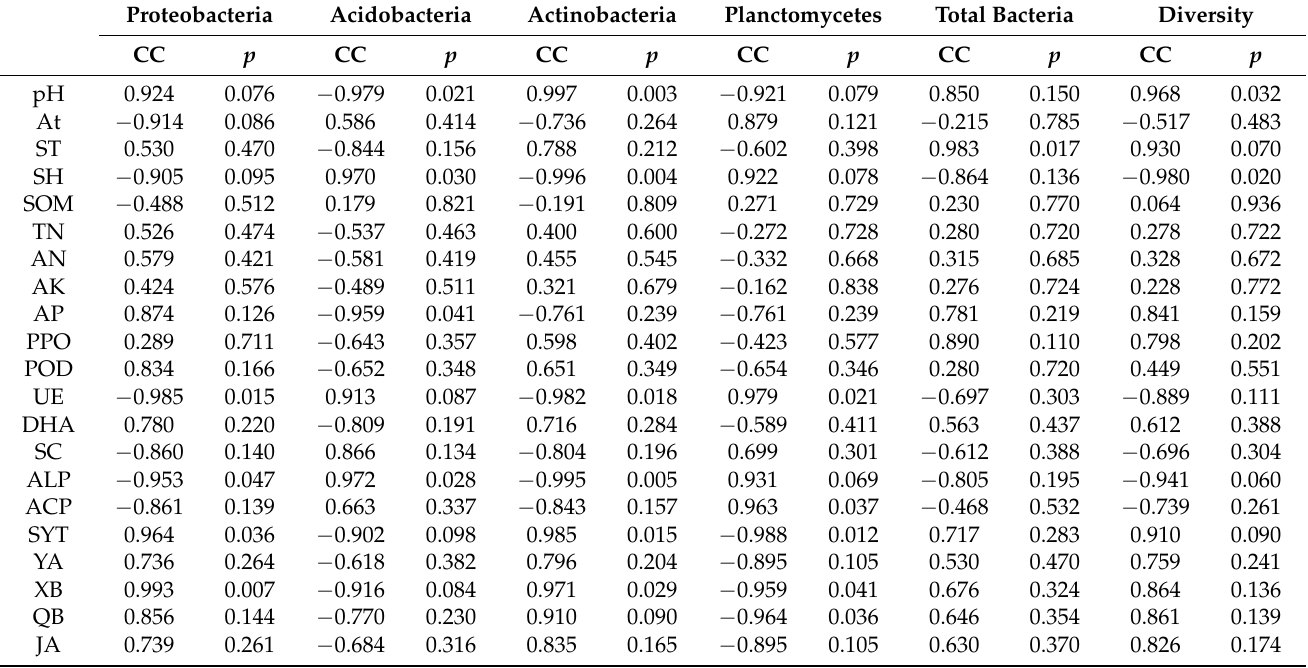
Table 5. Pearson correlation analysis of bacteria